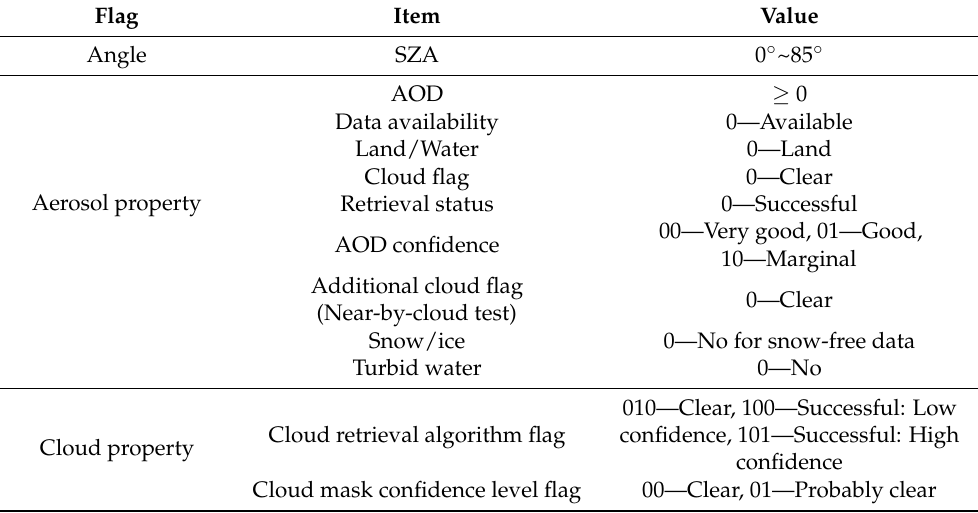
Table 2. Quality control for the AHI